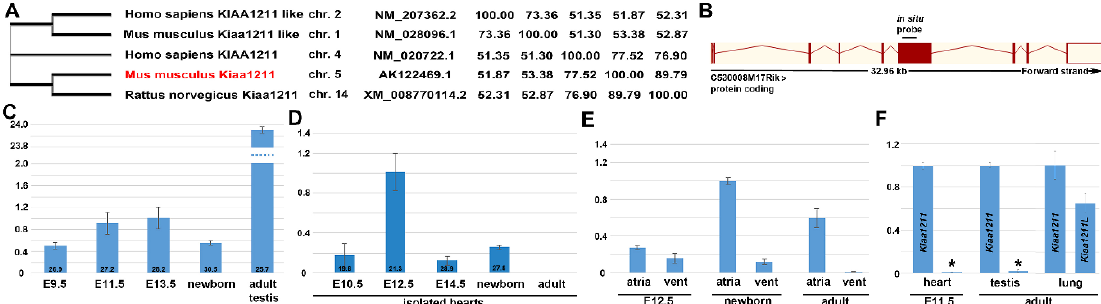
Figure1. Phylogenetic, genomicstructureandcomparativeqPCRanalysisofuncharacterized mKiaa1211 and mKiaa1211L genes. ( A ) Based on NCBI Reference Sequence similarity, mKiaa1211 (originally called C530008M17Rik ) and Kiaa1211L mouse paralogs, along with human and rat orthologs were aligned and a phylogenetic tree was constructed without distance corrections. Chromosomal locations, NCBI Reference Sequence numbers, and the percent identity matrix (created by Clustal2.1) are shown. ( B ) Ensemble schematic of mouse mKiaa1211 6835 bp transcript, with 9 exons (boxes) of 15 total shown. Lines connecting the boxes are introns. Filled boxes are coding sequence, and empty, unfilled boxes are the 3 (cid:48) untranslated region. The site of the mKiaa1211 in situ hybridization probe used in Figures 2–5 is indicated. ( C–E ) Quantitative PCR analysis of mKiaa1211 mRNA levels during development ( C ), in developmentally staged isolated hearts ( D ), and in separate atrial and ventricular heart chambers at E12.5, newborn, and adult stages ( E ). ( F ) Comparison of mKiaa1211 and mKiaa1211L (indicated via *) mRNA expression levels in isolated E11.5 hearts (25.8 vs. 32.4 median cycles) and adult testis (23.6 vs. 31.1 median cycles) but roughly equivalent low levels in adult lungs. qPCR data are presented as a logarithmic plot of relative expression, where a value of 1 indicates no di ff erence between E13.5 whole embryo in ( C ), E12.5 isolated heart in ( D ), and newborn atria in ( E ); and values < 1 indicate reduced and > 1 indicate increased expression. Error bars represent